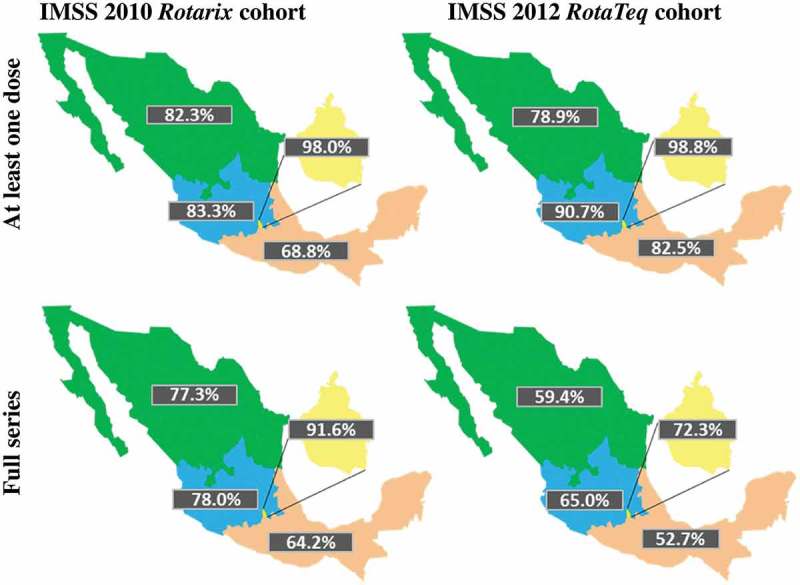
Rotarix and RotaTeq vaccine coverage (at least one dose and full series) by region.IMSS: Instituto Mexicano del Seguro Social; Rotarix: two-dose rotavirus vaccine; RotaTeq: three-dose rotavirus vaccine; Green: North region; Blue: Central region; Pink: South region; Yellow: Mexico City.